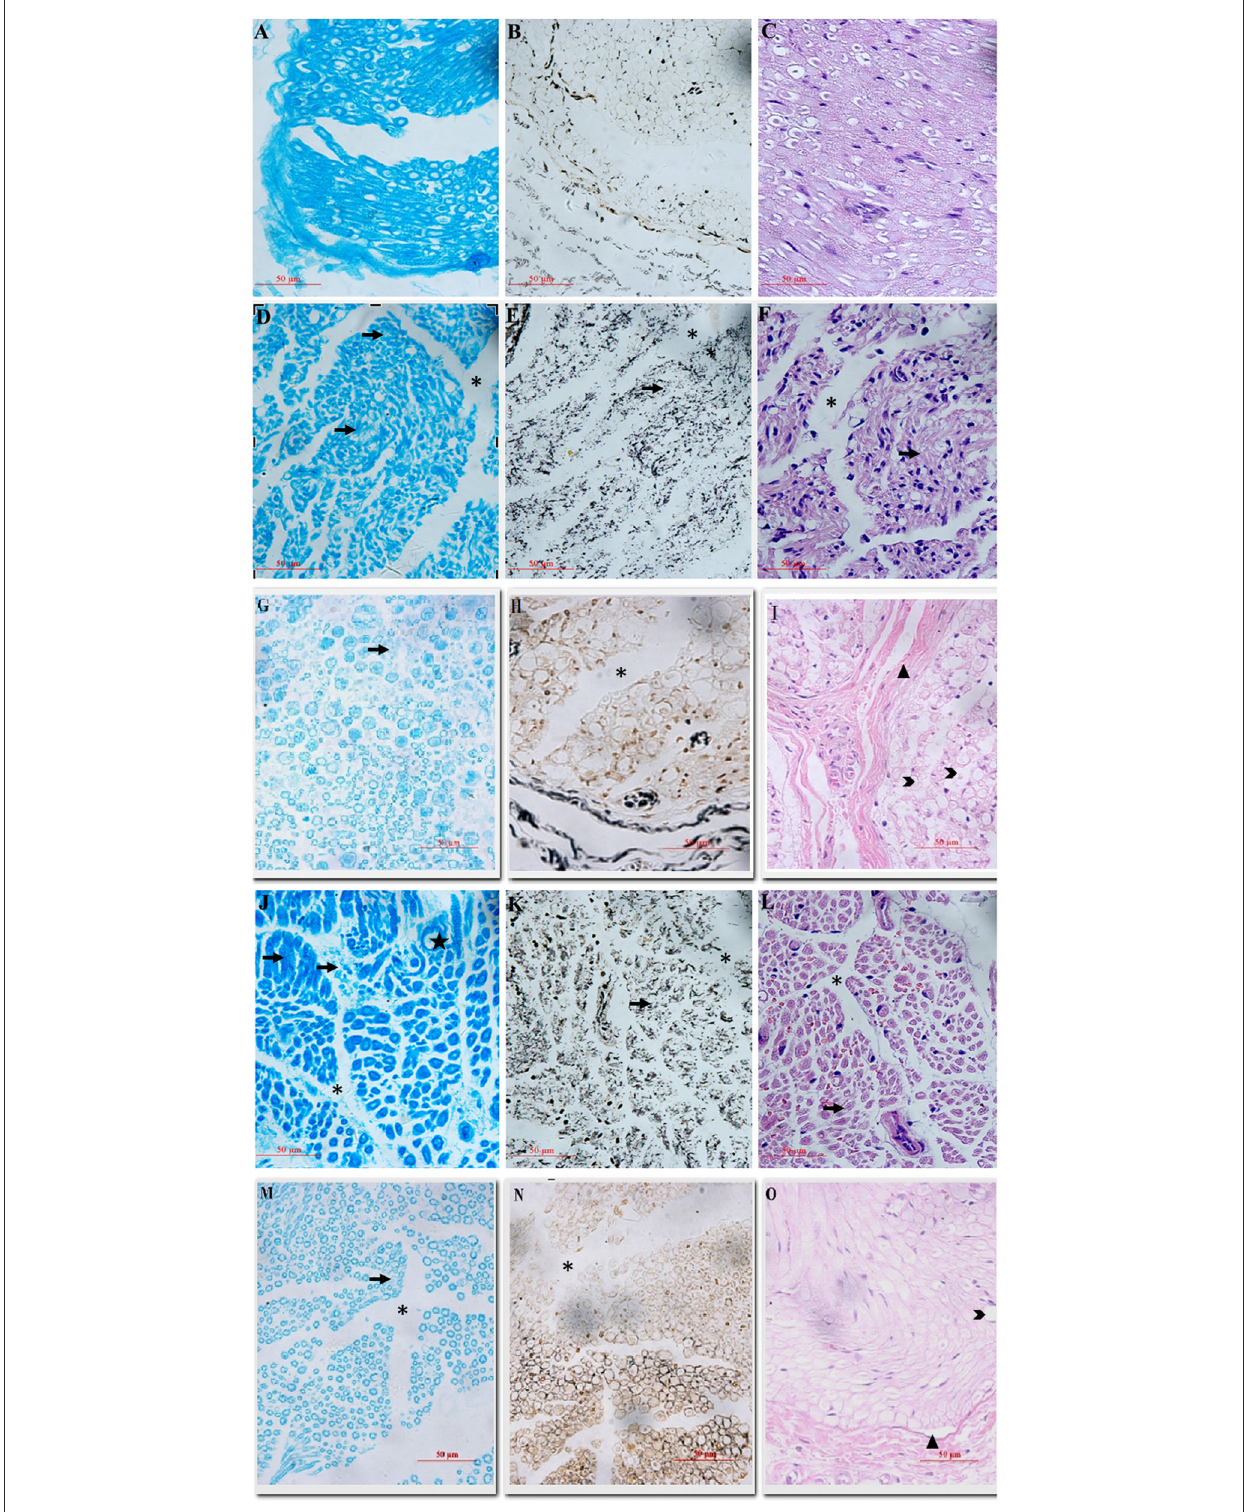
FIGURE2 The general views of histological sections stained by Fast blue, silver and H&E. (A–C) Sham group: well-arranged and distributed nerve fibers were observed; (D–I) vehicle groups at 7 and 14 days: typical features of peripheral nerve injury after 7 days could be seen in (D–F) , including myelin loss with Wallerian degeneration (arrow), and endoneurial edema (*). (G–I) A further decrease in nerve fiber density, disruption of fiber arrangement, and a marked increase in fibrosis (triangle) and axonal vacuolization (arrowhead) at day 14. (J–O) Melatonin groups at 7 and 14 days: compared with vehicle group, less axonal degeneration and vacuolization, as well as fibrosis were observed, with more regenerating axon clusters (star) and the nerve fibers were are neatly